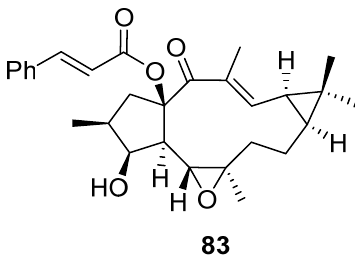
Figure 9. Chemical Structure of jolkinol B or EM-E-11-4 ( 83 ).